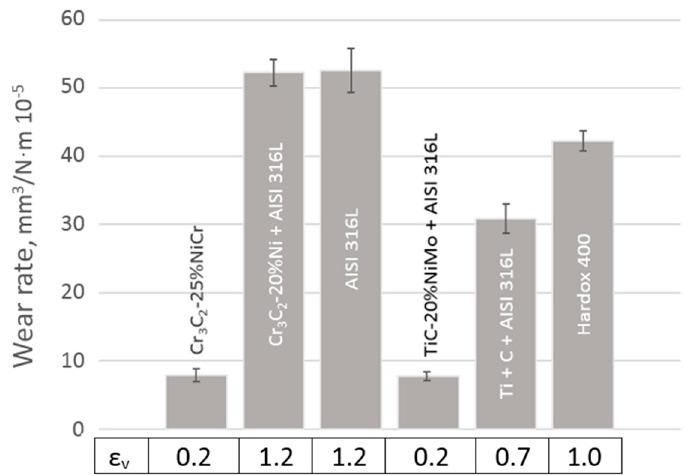
Figure 7. Wear rates and relative volumetric wear resistance ( ε ν ) of HVOF sprayed coatings to Hardox 400 steel at ARWW.